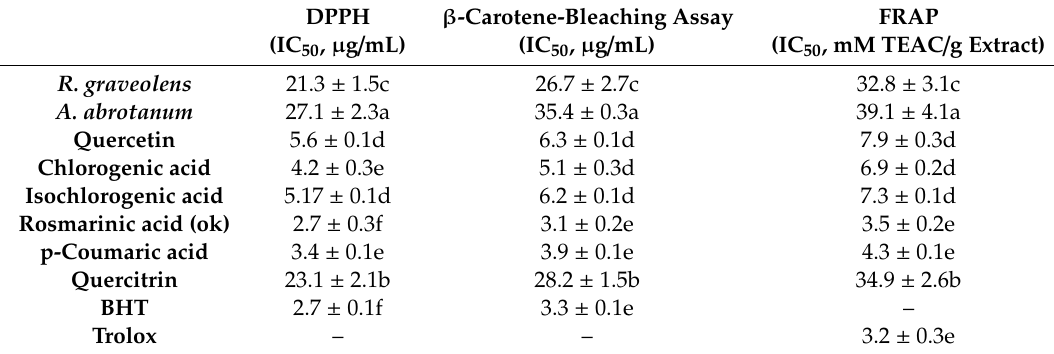
Table 2. Antioxidant activities of Ruta graveolens and Artemisia abrotanum leaf extracts and the identified polyphenols according to the 2,2-diphenyl-1-picrylhydrazyl (DPPH), β -carotene bleaching, and ferric-reducing antioxidant power (FRAP) assays.